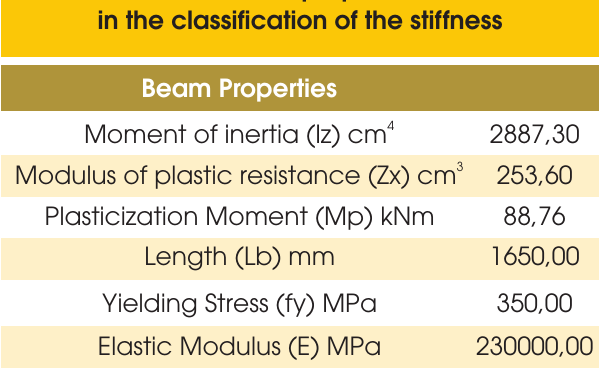
in the classification of the stiffness